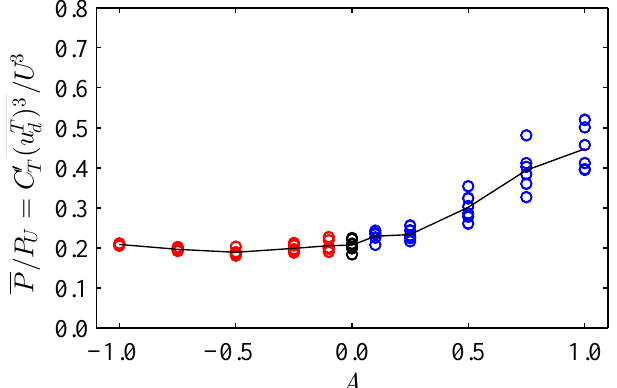
Figure 1. Wind farm power production, normalized by power available in the high-altitude flow, is shown for each individual wind turbine (symbol) and for the wind farm mean (solid line) as a function of the forcing parameter A . Cases that correlated high-speed flow with upward and downward forcing are colored in red and blue, respectively.